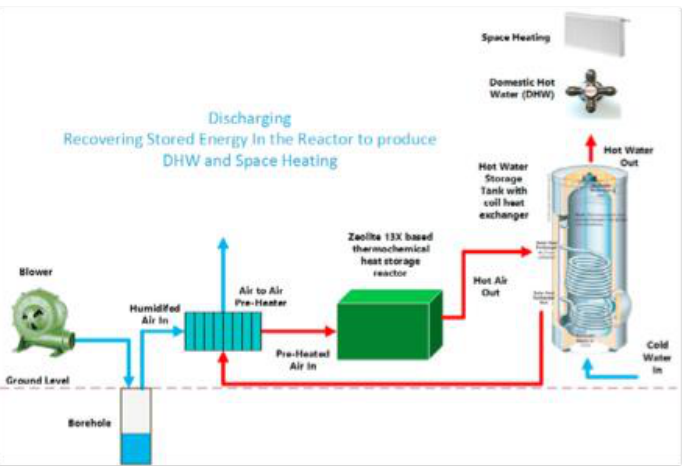
Figure 6. Illustration from Gaeini et al. [15]. Energy is sourced from the borehole.